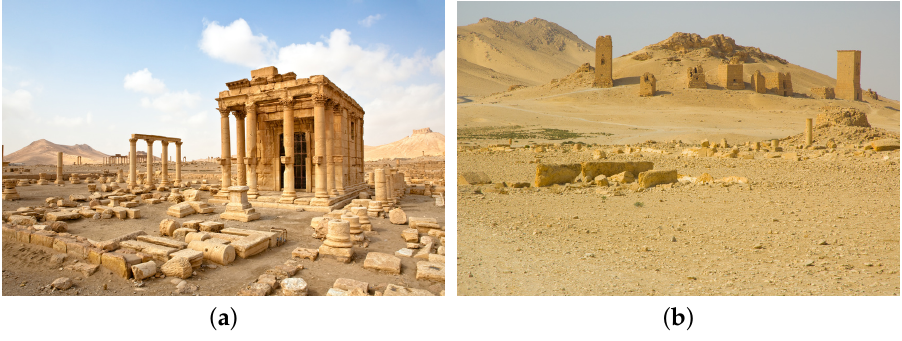
Figure 3. Palmyra’s archaeological site: Temple of Bel ( a ) c (cid:13) Dario Bajurin and tower tombs in the background ( b ) c (cid:13)